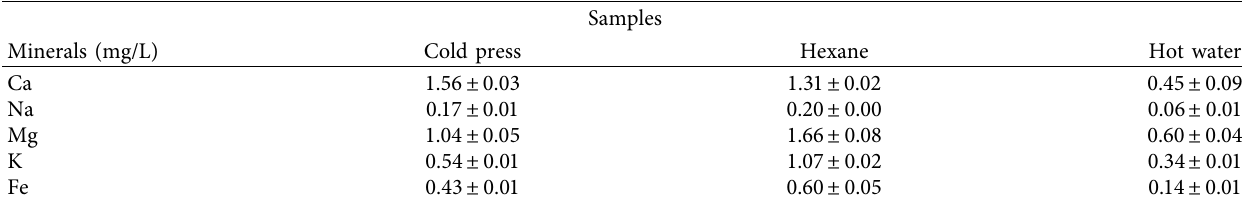
Table 3: Mineral content of the A. foribunda butter extracted by hexane, cold press, and hot water.